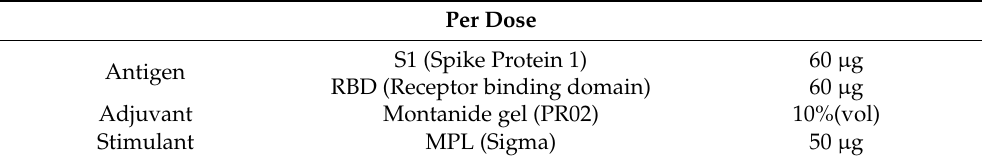
Table 1. Materials used in the construction of vaccines are in the table. S1 protein and RBD protein were used as antigens, Montanide gel as an adjuvant, and MPL as a stimulant in the ratio as above.